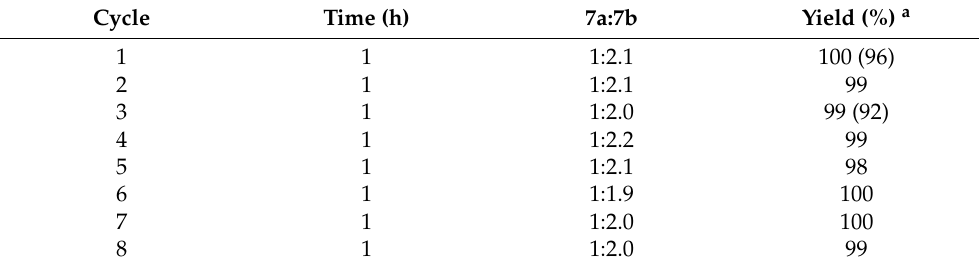
Table 4. Hydrosilylation reaction of 2-methylbut-3-yn-2-ol ( 7 ) and triethylsilane ( 3 ) under thermomorphic condition.